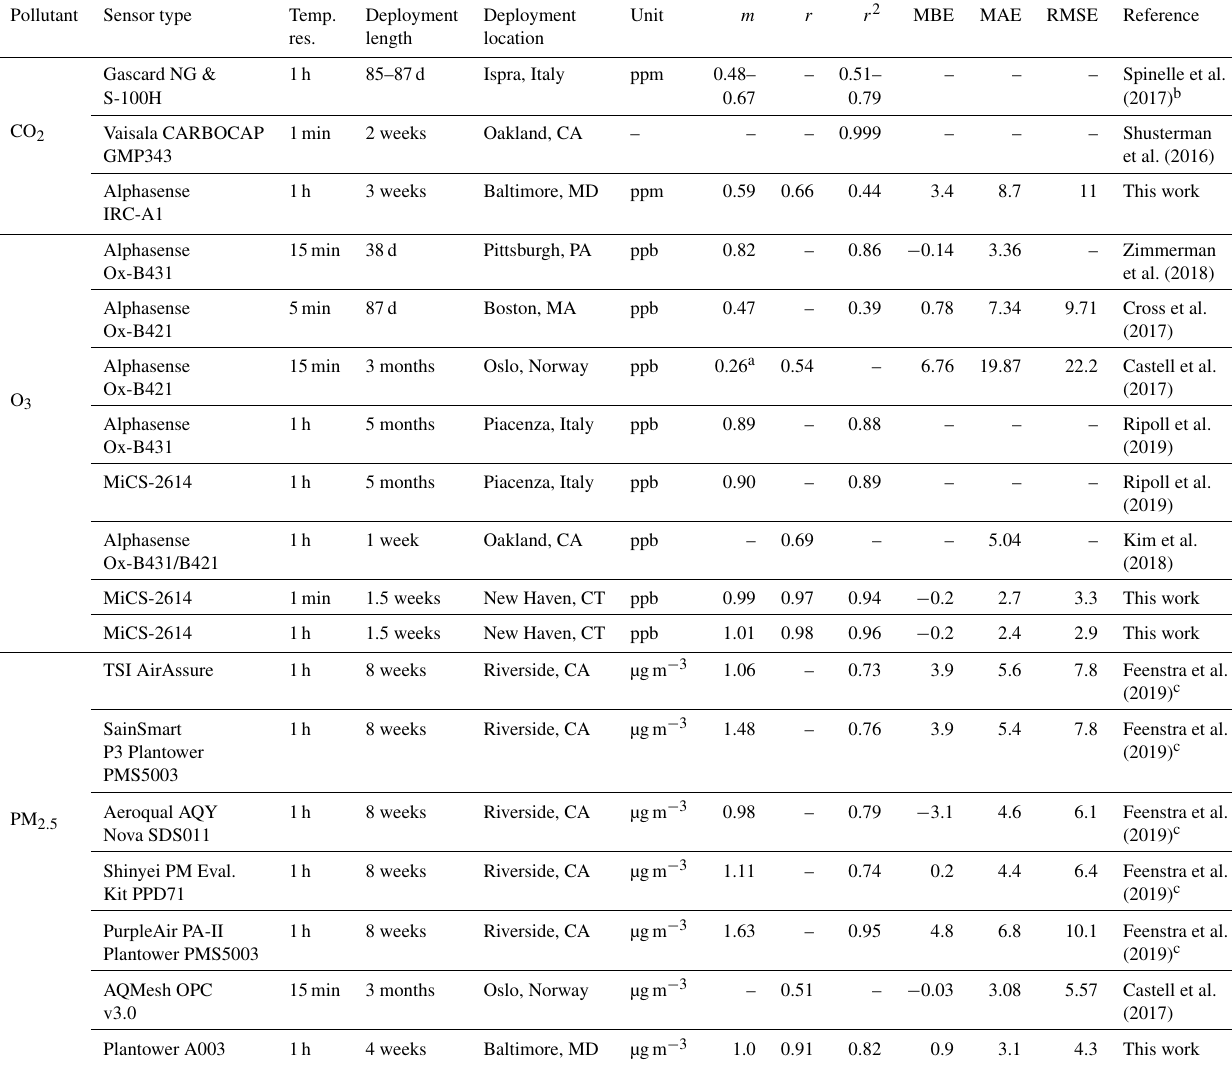
a Slope and intercept value from unit 688150 in Table 2. b From correlation using an artificial neural network calibration. c Top five performing (by r 2 )